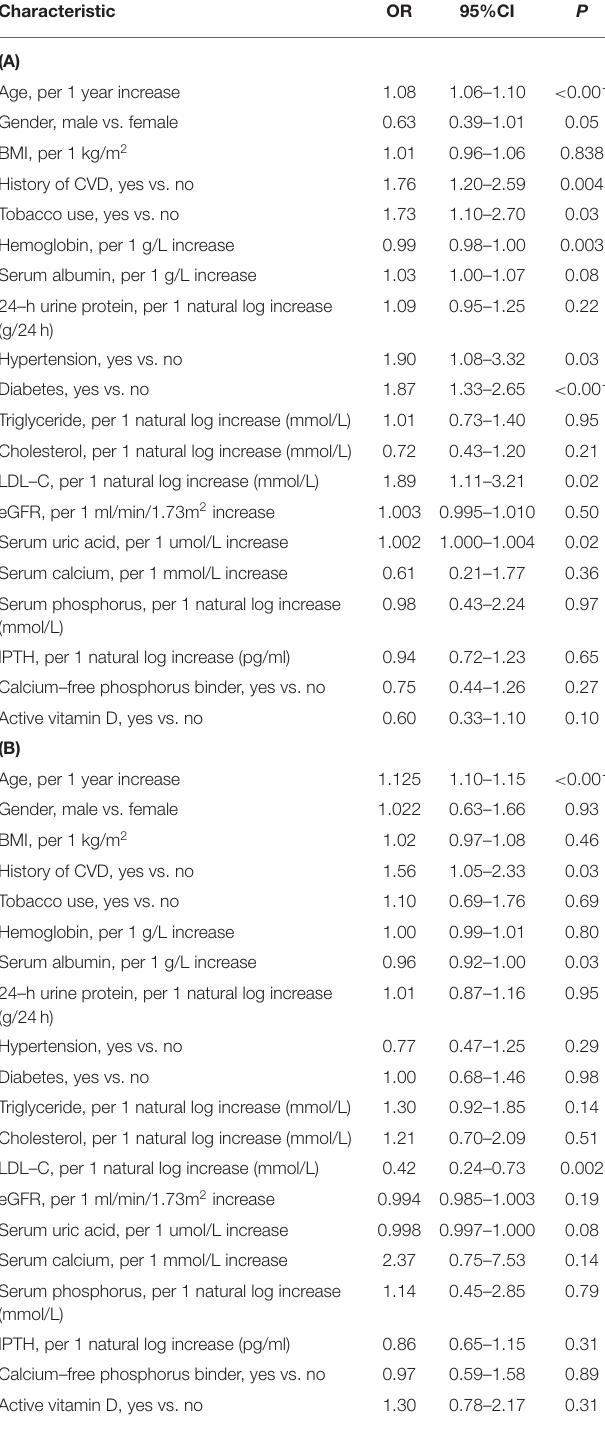
TABLE 3 | Survival analysis for all-cause mortality and cardiovascular events with AAC or CVC as the exposure factor. Patients